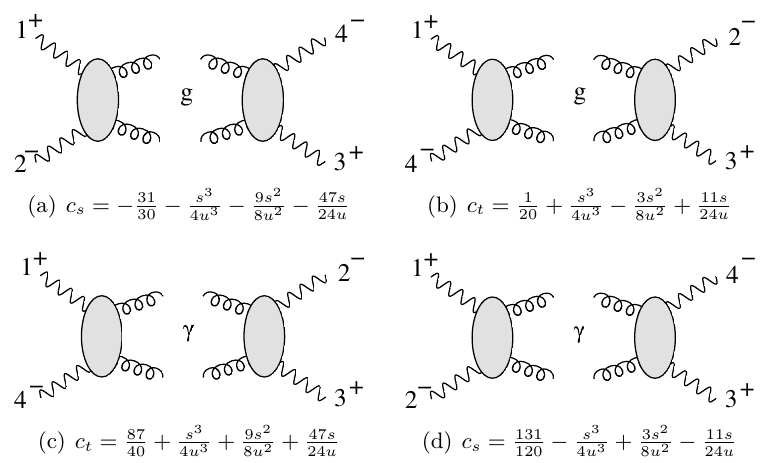
Figure 3 . The s - and t -channel bubble coefficients for the graviton and photons in Einstein-Maxwell theory multiplying ( T µν ) 2